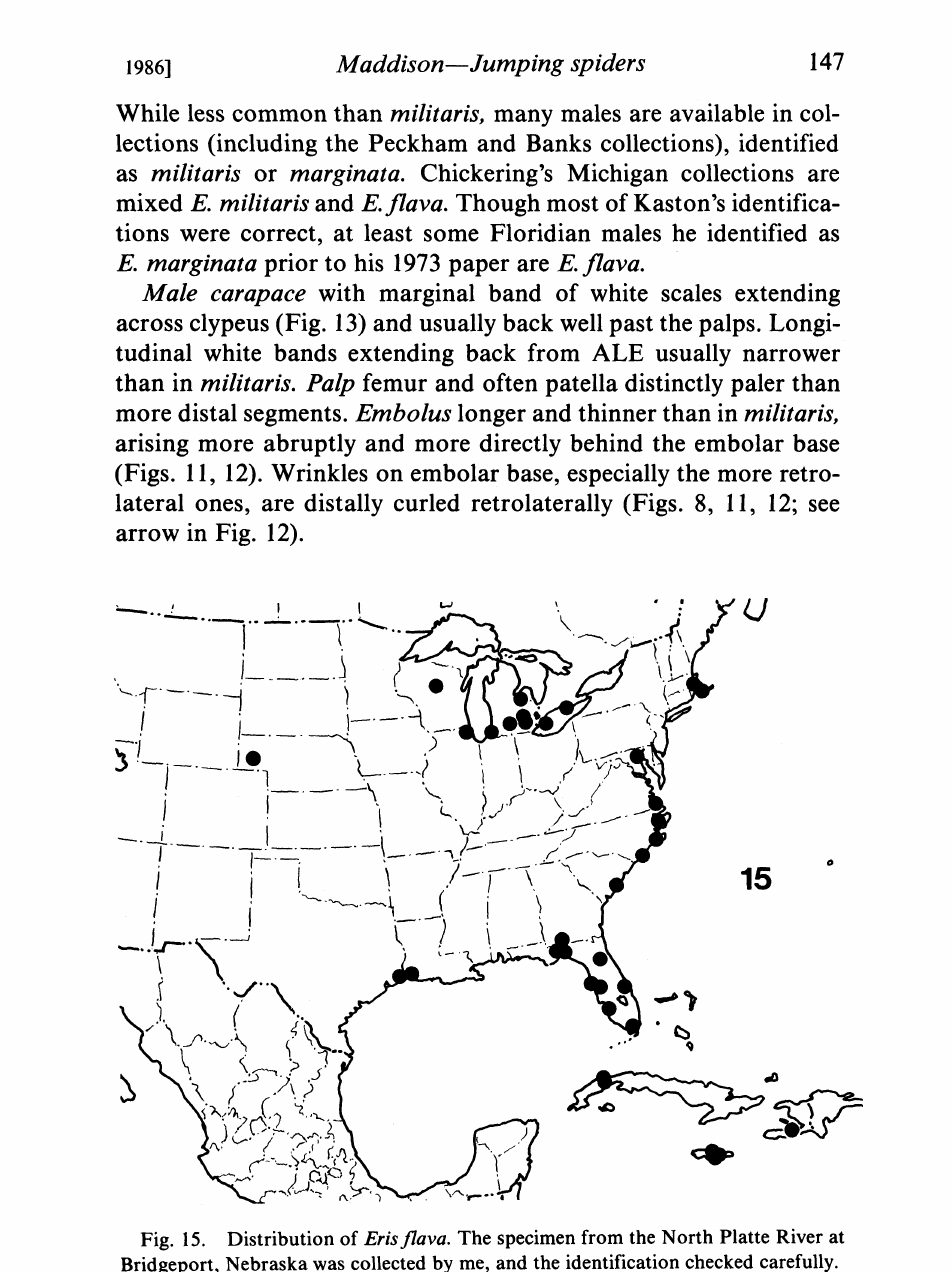
Fig. 15. Distribution of Erisflava. The specimen from the North Platte River at Bridgeport, Nebraska was collected by me, and the identification checked